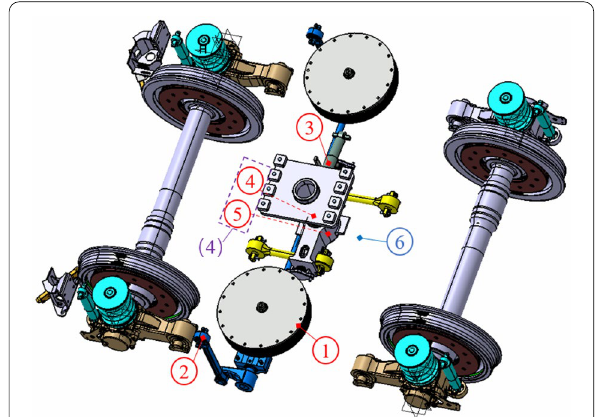
Figure 6 Reference point location